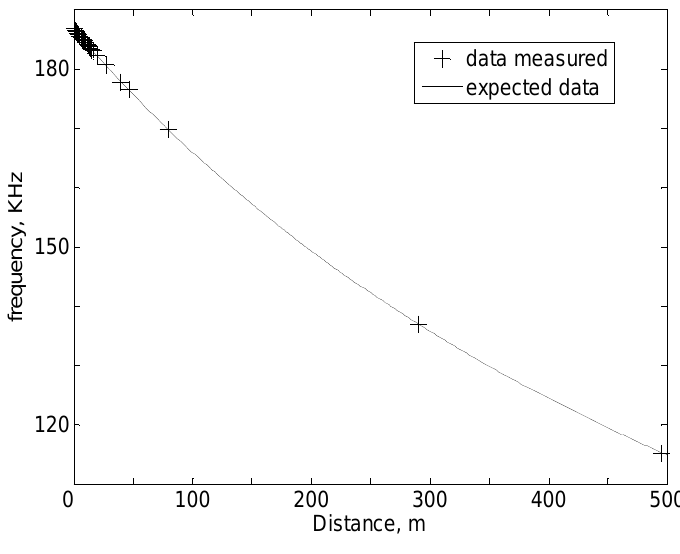
Figure 4. Frequency measured versus